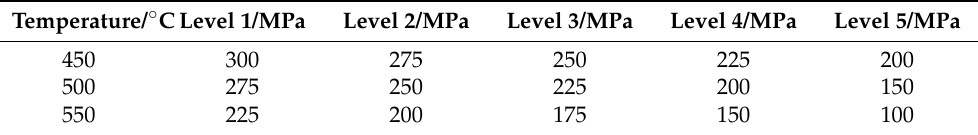
Figure 3. Schematic diagram of creep test sample size. Table 2. Different load levels for creep tests. Table 2. Different load levels for creep tests.